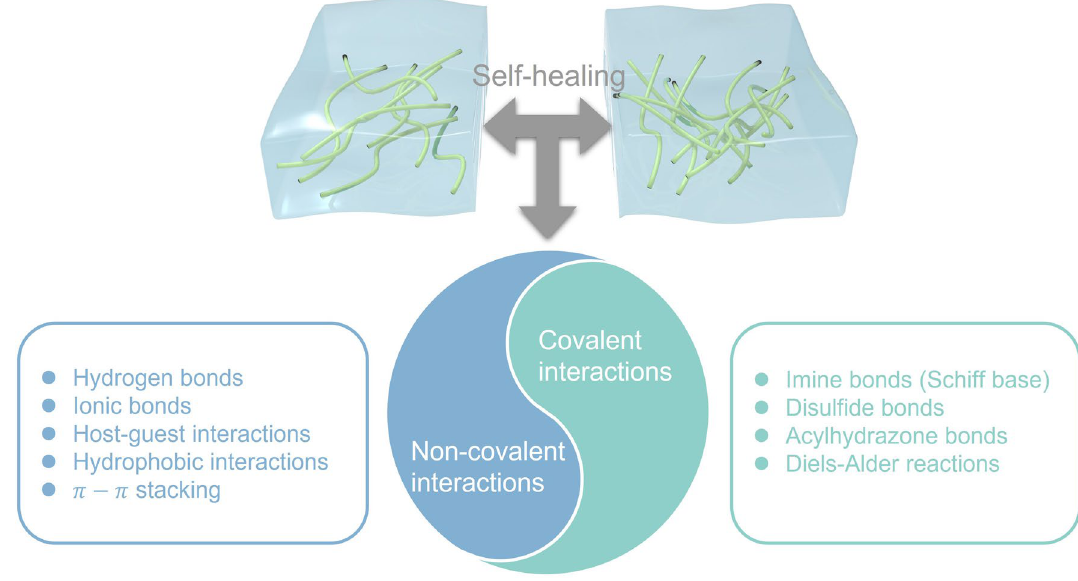
Fig. 6 Summary of self-healing